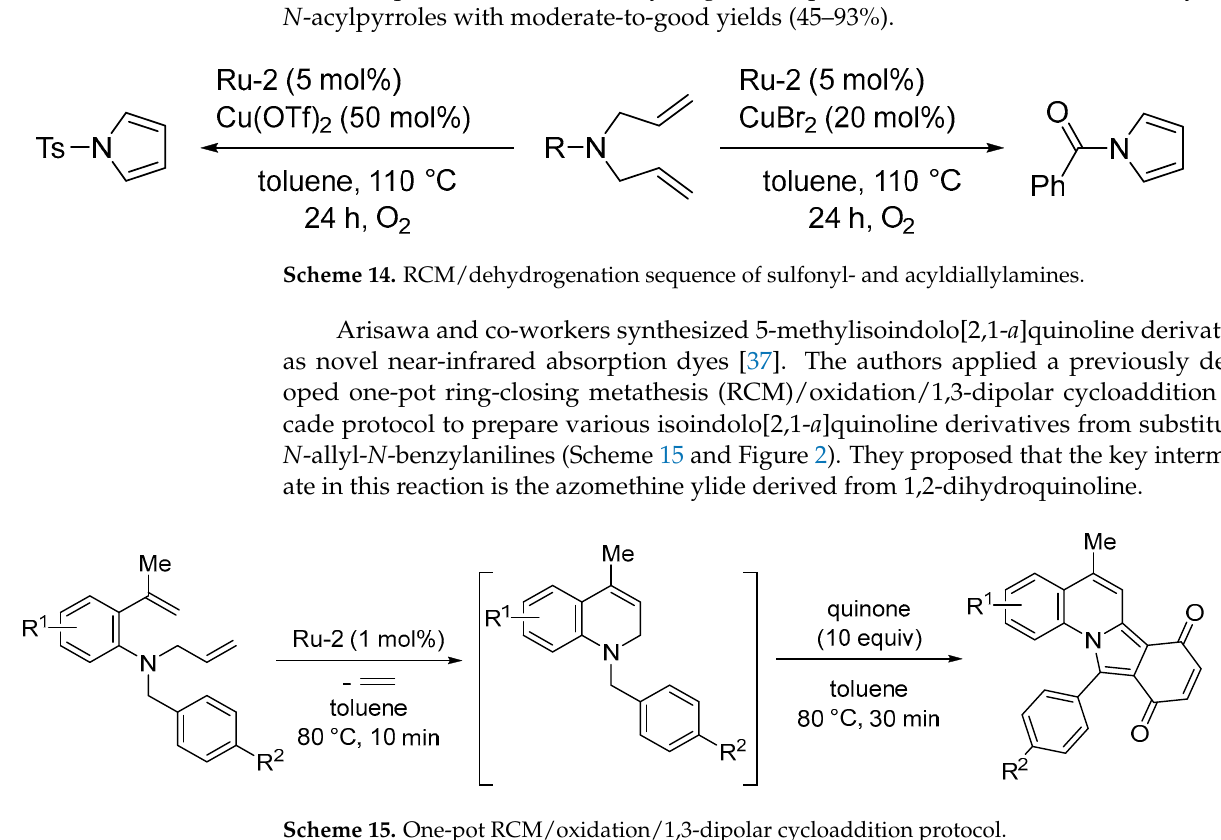
Scheme 15. One-pot RCM/oxidation/1,3-dipolar cycloaddition